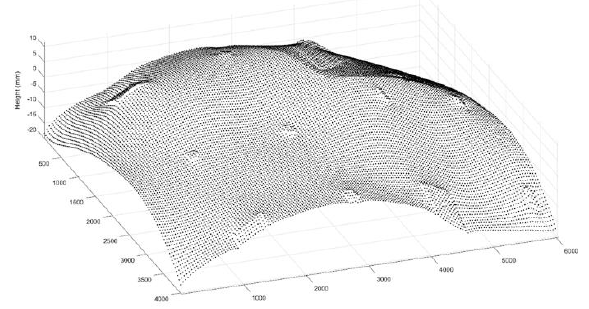
Figure 13 Distorted surface arising from direct reconstruction from photometric normals.